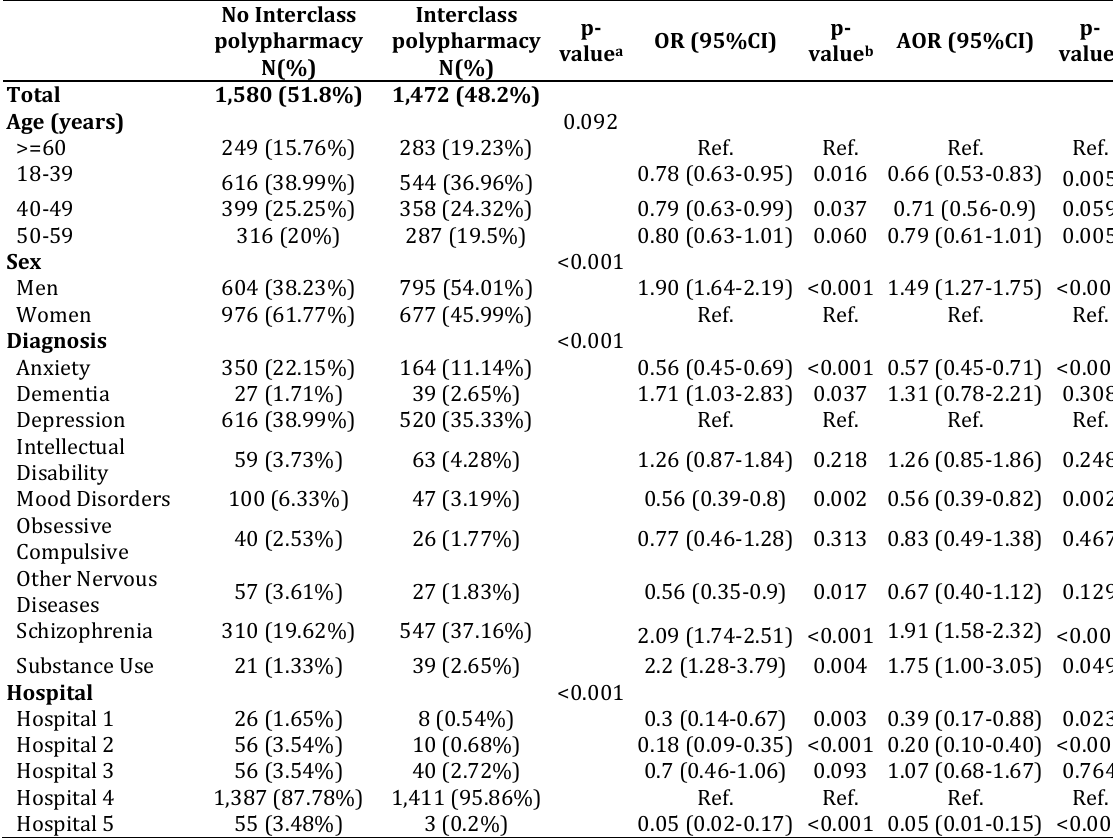
Table IV Unadjusted and Adjusted odds ratios (ORs) for interclass polypharmacy